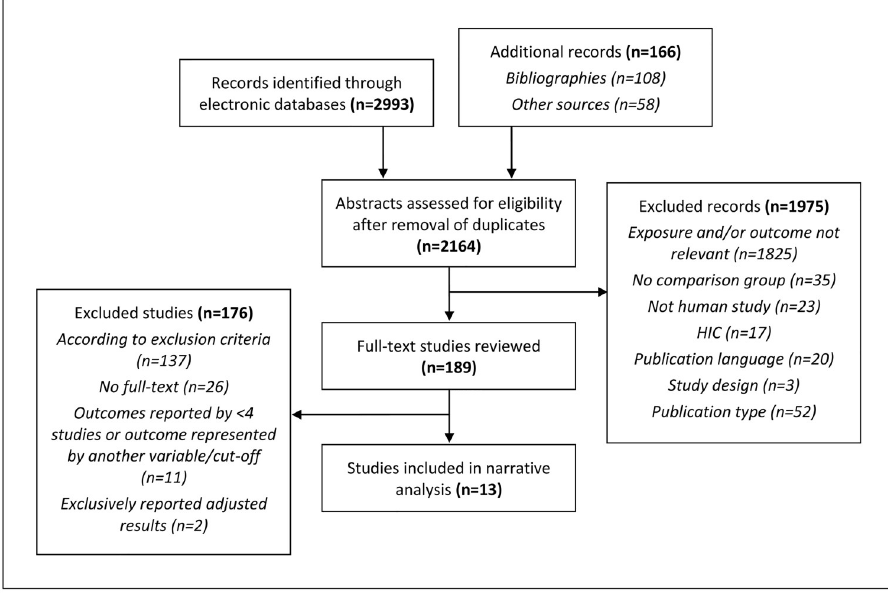
Fig 1. Flow diagram of the review process. CVD–cardiovascular disease, HIC–high-income country, n–number of studies.